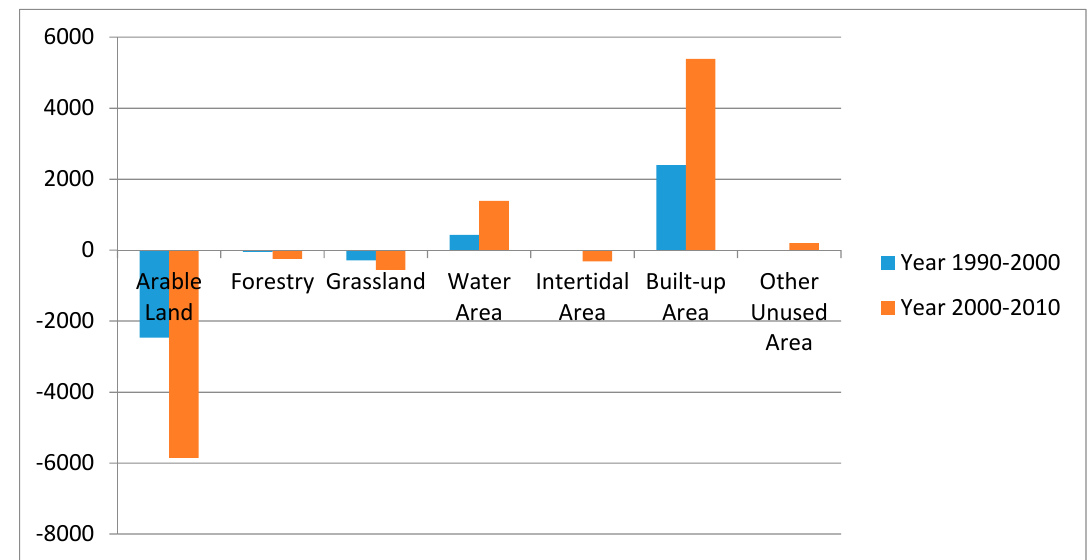
Figure 4. Statistical amount changes of land use in Jiangsu province (unit: km 2 ).